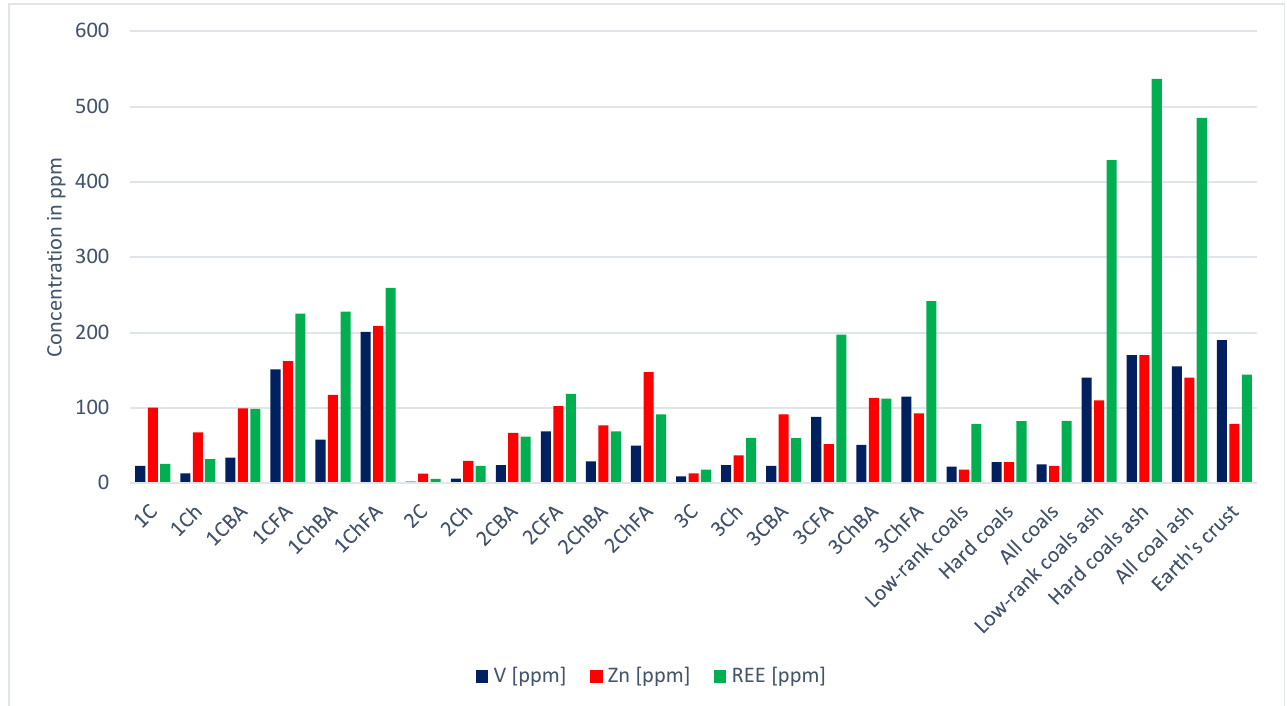
Figure 8. The V, Zn, and REE content of char ashes and their Clarke values [21].